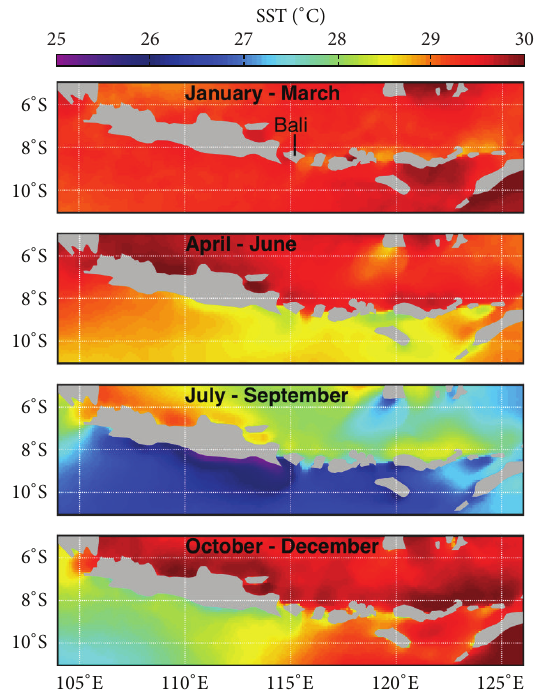
Figure 1: Seasonal sea surface temperature (SST) climatology of the region showing lower temperatures in the second half of the year when M. ramsayi reports are the highest (M. Erdmann and S. Fautz pers comm